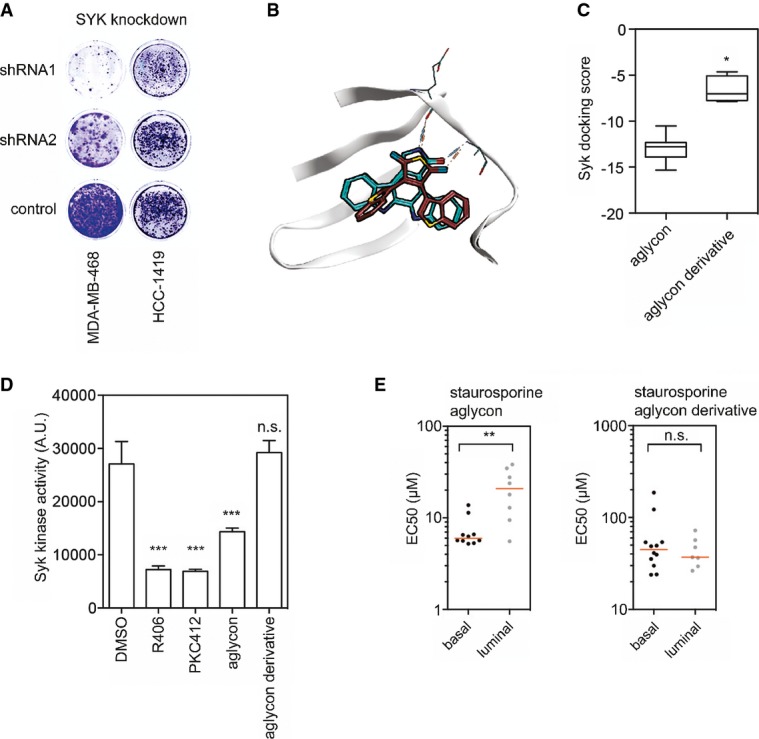
Structure–activity relationship between PKC412 analogs and SYK inhibition
A MDA-MD-468 (basal-like) or HCC1419 (luminal) cells were infected with two independent SYK-shRNA or control vectors and plated at equal cell numbers. Plates were stained with crystal violet after 10 days.

B Structural representation of in silico docking poses of staurosporine aglycon (cyan) or a derivative lacking the closed central benzene ring (red) into the SYK kinase ATP binding pocket.

C Quantification of docking scores from (B). *P < 0.05, Mann–Whitney U-test.

D In vitro kinase assay with recombinant SYK kinase incubated with vehicle (DMSO), staurosporine aglycon, staurosporine aglycon derivative or PKC412. The SYK inhibitor R406 was used as a positive control. n = 4; error bars indicate standard deviation. ***P < 0.001, Mann–Whitney U-test. n.s. = not significant.

E EC50 values of a cell line panel treated with the compounds from (C). **P < 0.01. n.s. = not significant.